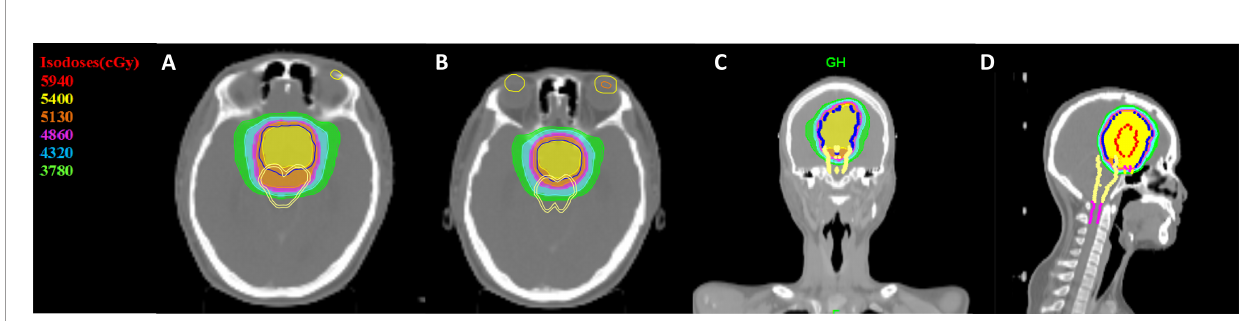
FIGURE 1 | Dose distribution in a CN patient treated with IMRT. Color-wash areas: 59.40Gy (red), 54.00Gy (yellow), 51.30Gy (orange), 48.60Gy (purple), 43.20Gy (blue), 37.80Gy (green). CN, central neurocytoma; HT, Helical tomotherapy. (A, B) refer to cross section CT, (C) refer to coronal CT and (D) refer to